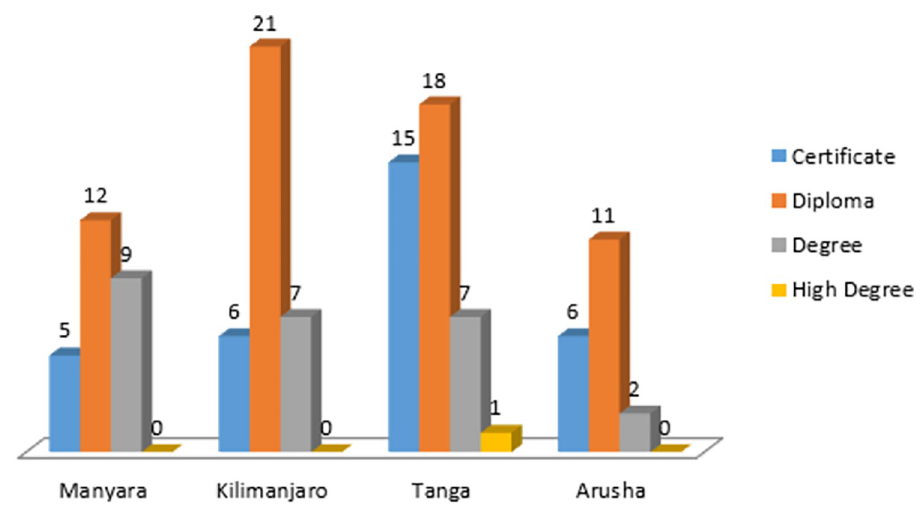
Fig 5. Distribution of participants by level of education in the four